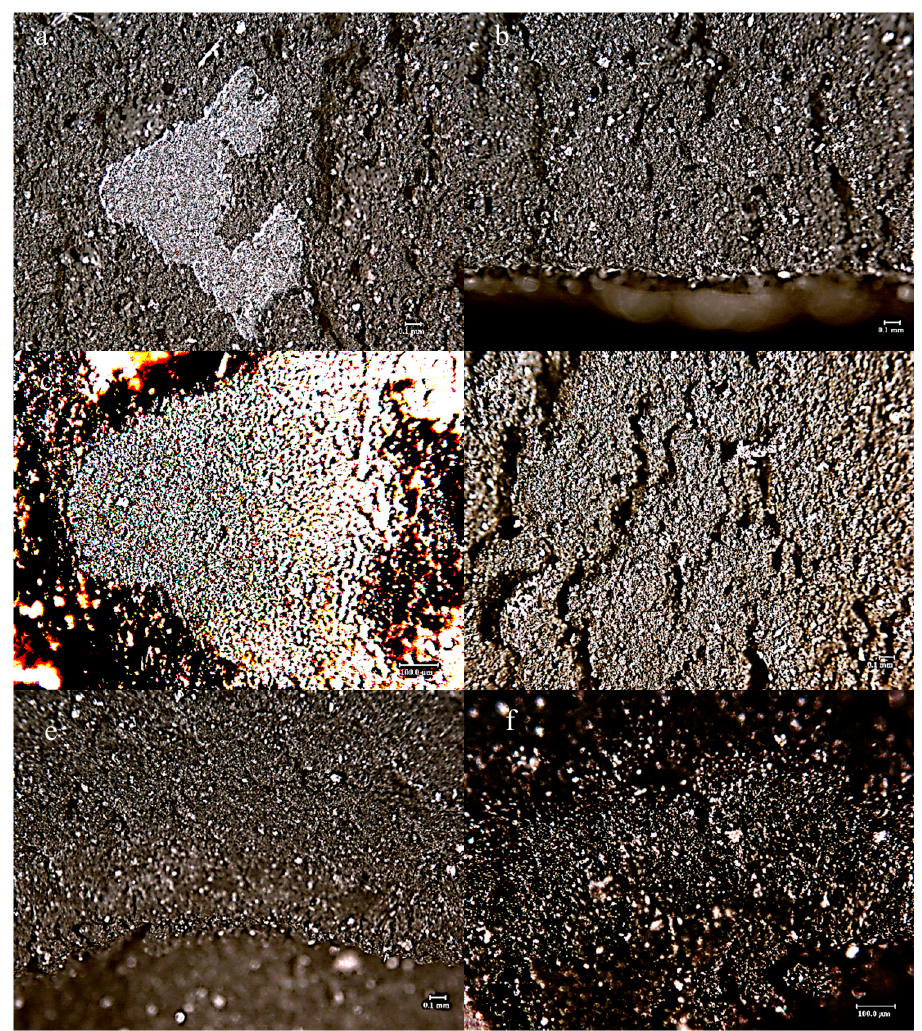
Figure 29. Adhesive 1 lap shear failure surfaces at di ff erent extension rates ( a , b ) 4 × magnification at 25 mm / min; ( c , d ) 10 × magnification at 25 mm / min; ( e ) 4 × magnification at 500 mm / min; ( f ) 10 × magnification at 500 mm /